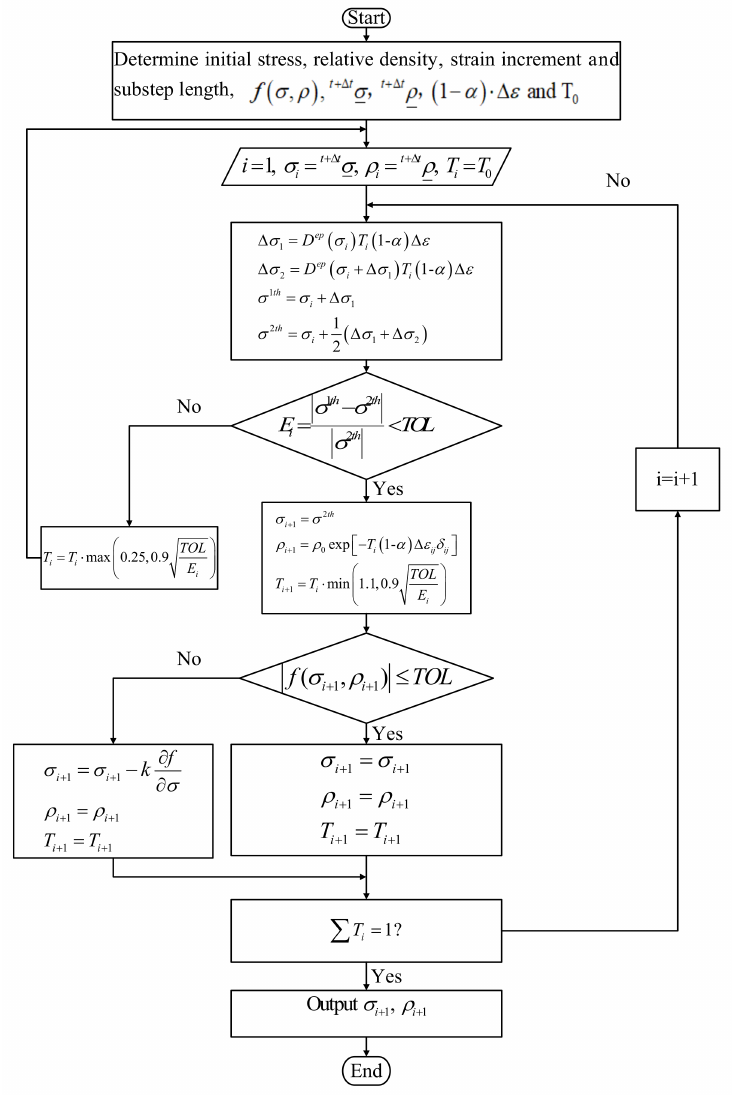
Figure 4. Stress-explicit integration method for automatic control